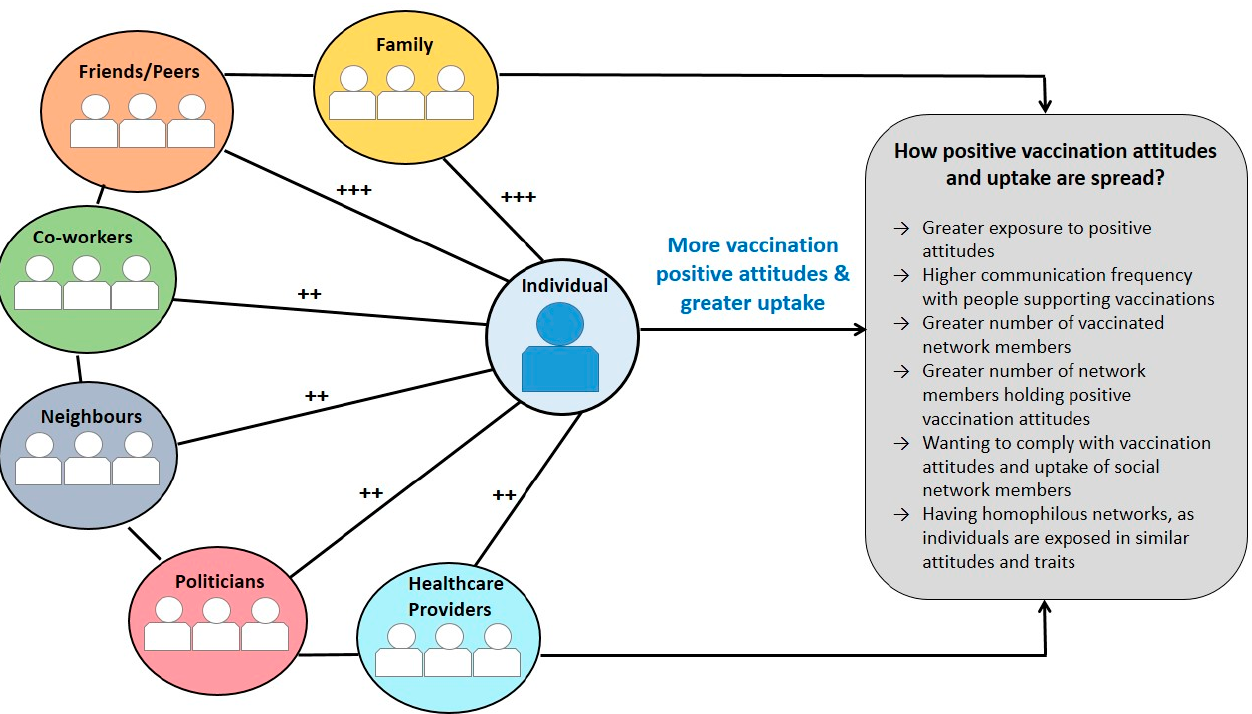
Figure 2. A summary of findings explaining how vaccination attitudes and uptake are transmitted within social networks. Note. ++ Lower influence on vaccination attitudes and uptake of individuals compared to other network members (family, peers and friends) based on the total number of studies reporting this information; +++ Higher influence on attitudes and vaccination uptake of individuals compared to other network members (neighbours, co-workers, politicians, healthcare providers) based on the total number of studies reporting this information.